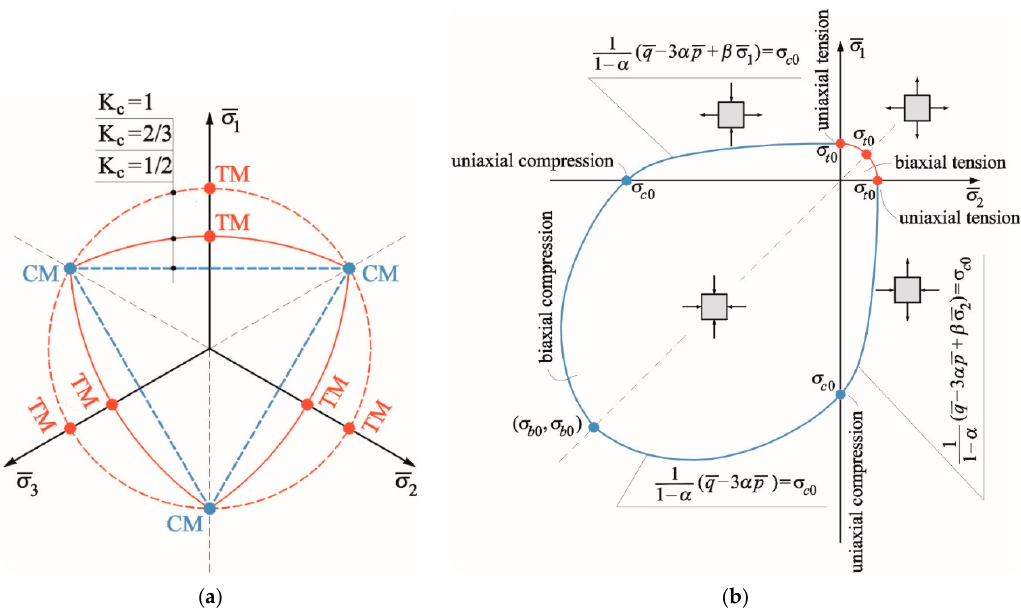
Figure 6. Yield surface in: ( a ) deviatoric plane; ( b ) plane stress. [43].